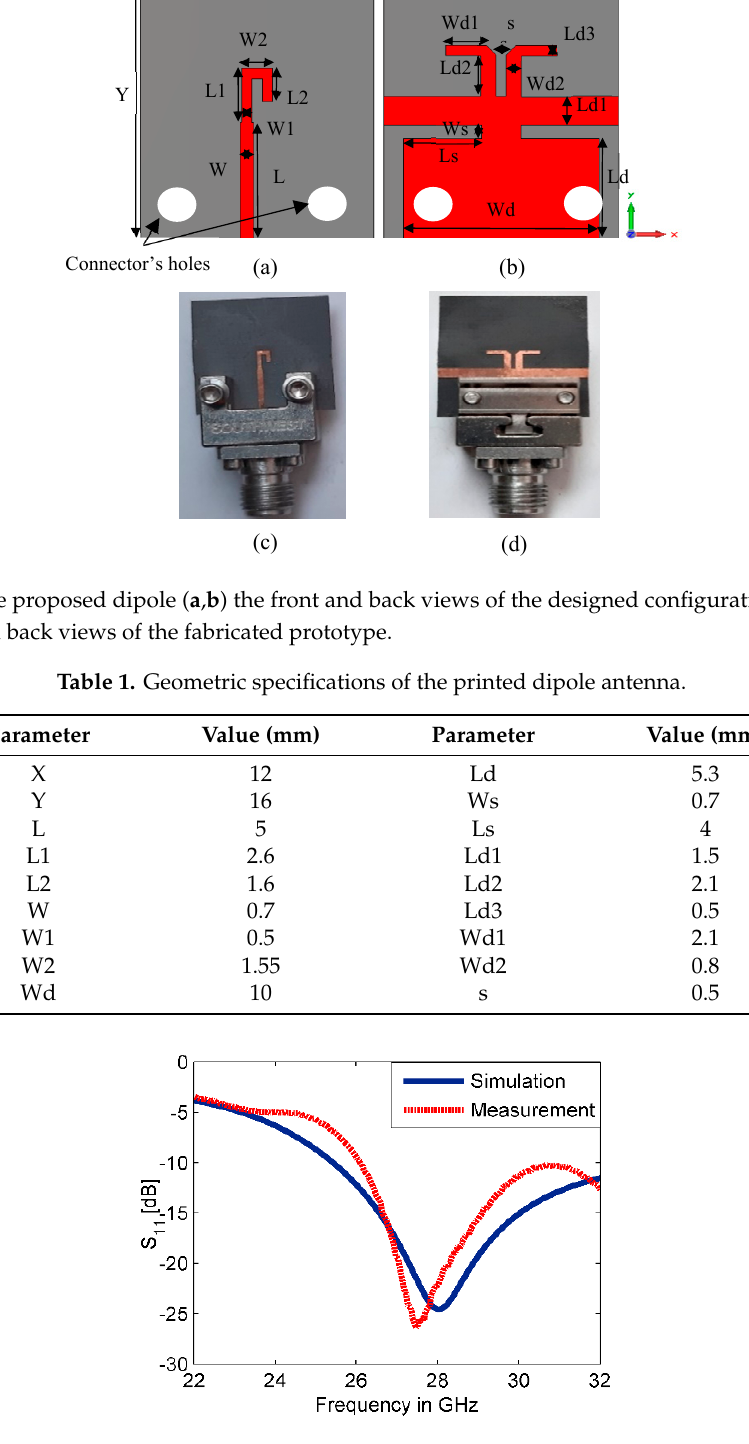
ffi cient of the dipole Figure 6. The reflection coefficient of the dipole antenna. Figure 6. The reflection coe